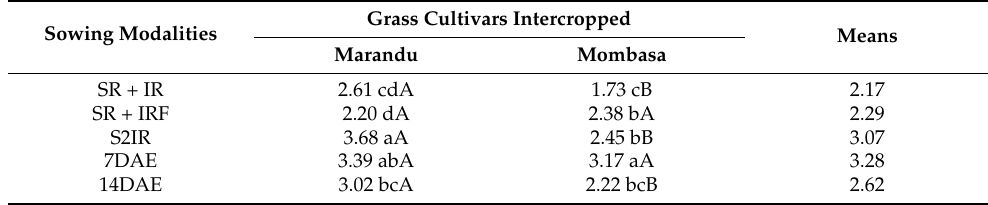
Table 5. Ammoniacal nitrogen as part of the total nitrogen (% of NH 3 -N/TN) of corn ( Zea mays L.) silage intercropped with Marandu ( Urochloa brizantha ) and Mombasa ( Megathyrsus maximus ) grasses in different sowing modalities. Grass Cultivars Intercropped Sowing Modalities